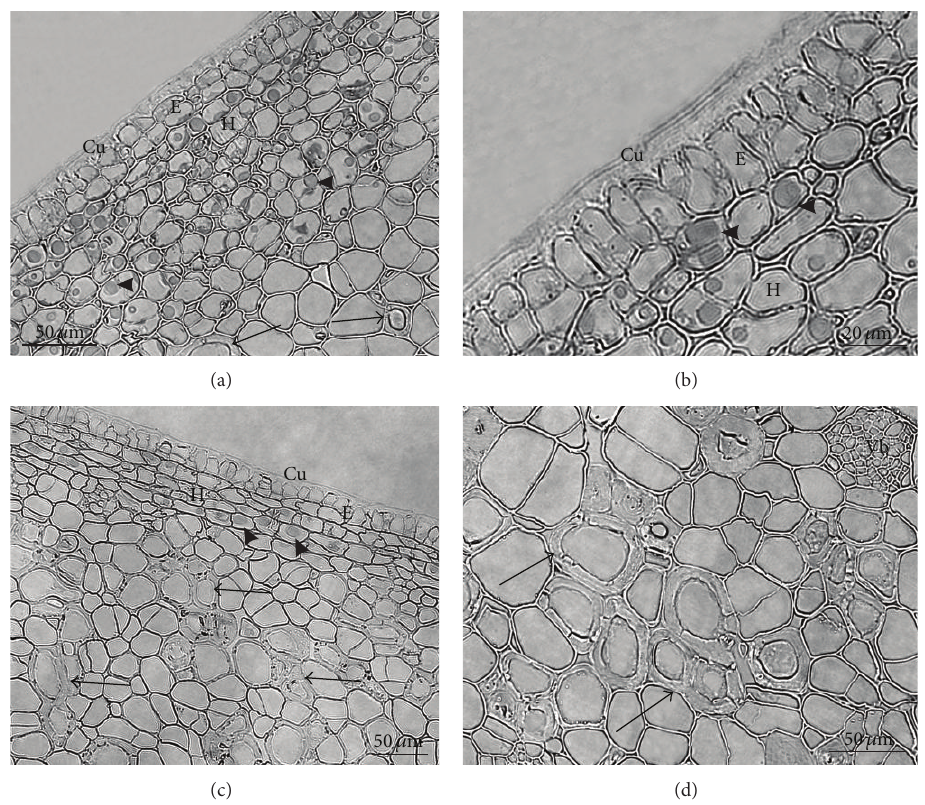
Figure 6: LM: fragments of the cross-sections through the “Clapp’s Favourite” ((a), (b)) and “Conference” ((c), (d)) peel at the fruit set stage; ((a)–(c)) visible divisions of the epidermal cells and spherical deposits in the hypodermis (arrowheads); ((a), (c), (d)) stone cells are visible in the parenchyma (arrows); Cu: cuticle, E: epidermis, H: hypodermis, P: parenchyma, and Vb: vascular